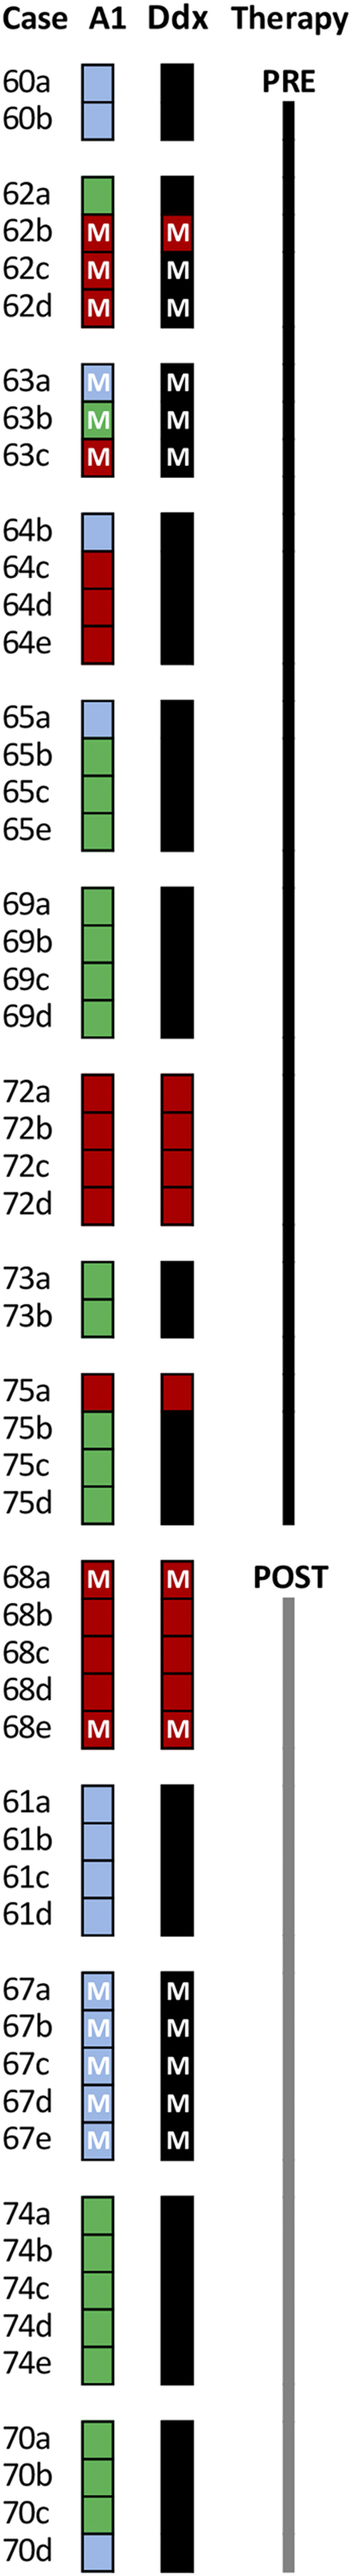
Transcriptional profiling and cluster analysis reveals intratumoral heterogeneity in 43% (6 of 14) of tumors.Intratumoral heterogeneity is defined as specimens from the same patient clustering into different groups by at least one analysis method (A1 or Ddx). Specimens were assigned to 1 of 3 groups by hierarchal clustering based on Euclidean distance of RT-qPCR results for A1 using 30 genes (SI Fig. 1, SI Table 3) and into 2 groups for Ddx by the 9 genes used for the Decision Dx panel (SI Fig. 2). “M” signifies a MGMT promoter methylation positive specimen. Specimens are grouped by patient and ordered by therapy. The 3 cluster groups for A1 are colored and concur with gene expression levels expected for the classical (blue), mesenchymal (green) and proneural (red) subgroups. The specimens in the red cluster group for Ddx have the highest individual scores using the Ddx algorithm suggestive of a better outcome and proneural subtype. The specimens in the black cluster group are the remaining specimens (with lower Ddx scores) and thus comprise specimens of the classical and mesenchymal subtypes.